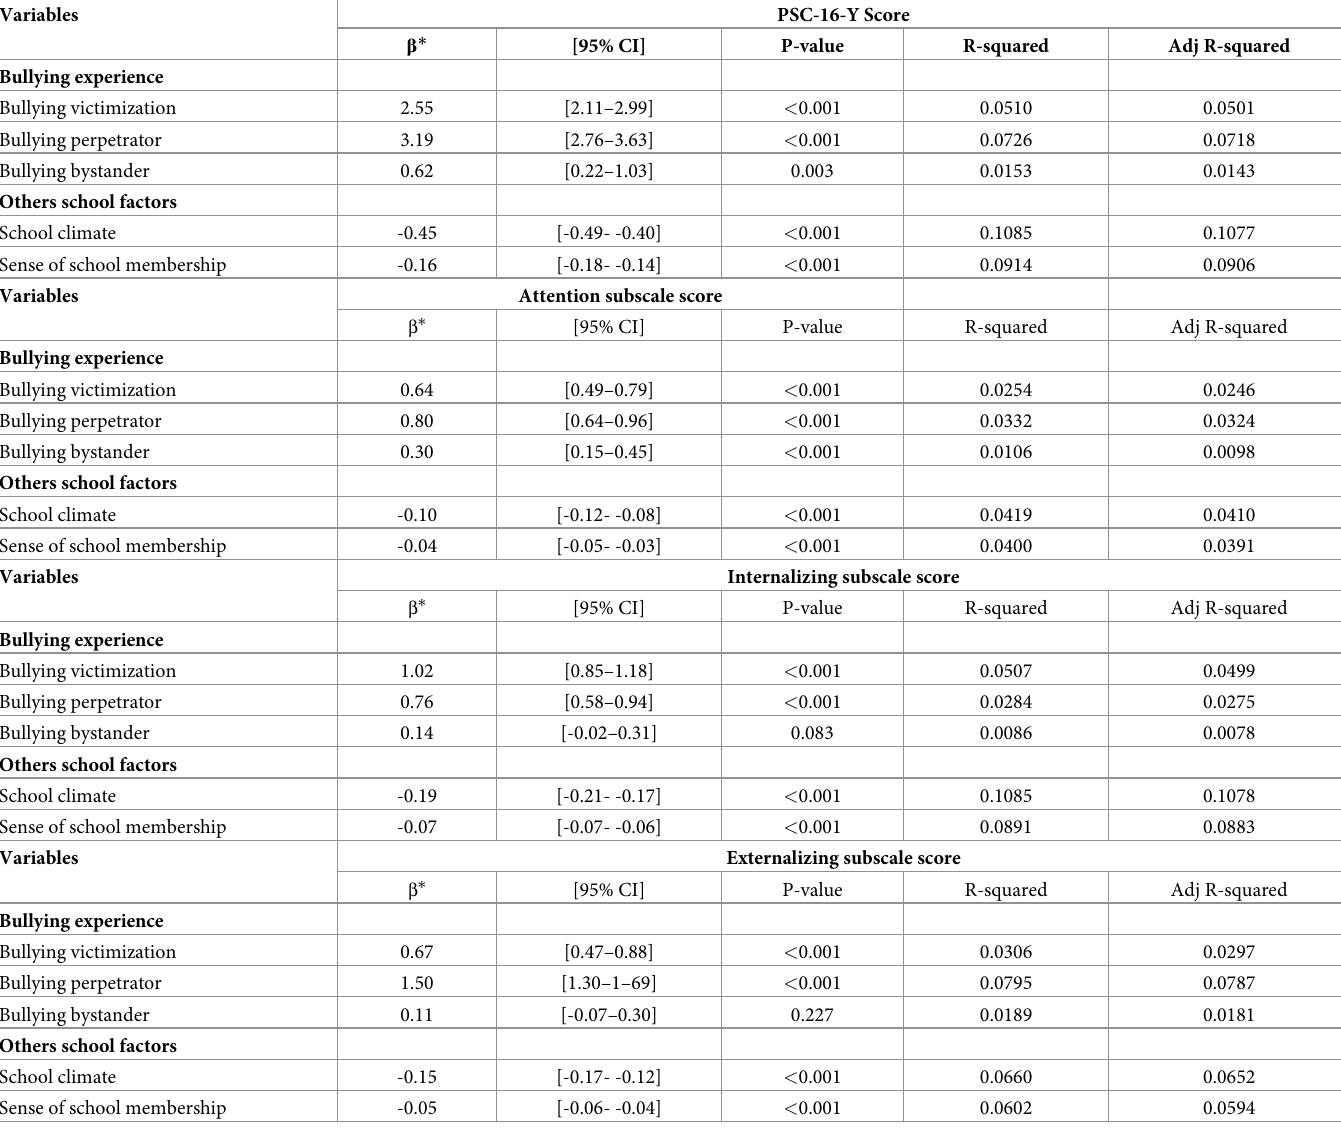
Table 7. a: Risk and protective factors associations with PSC-16-Y. b: Risk and protective factors associations with Attention subscale score of PSC-16-Y. c: Risk and protective factors associations with Internalizing subscale score of PSC-16-Y. d: Risk and protective factors associations with Externalizing subscale score of